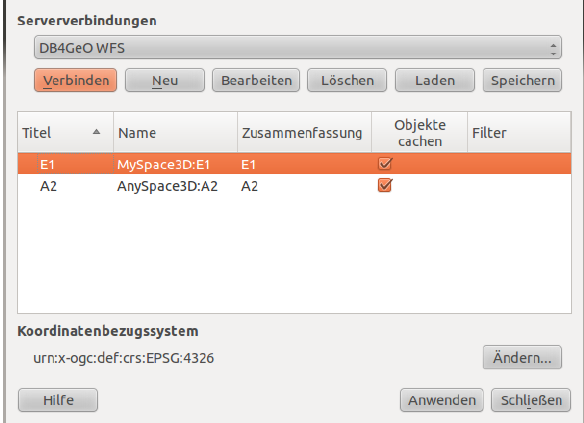
Figure 11: Selecting an object out of DB4GeO via WFS